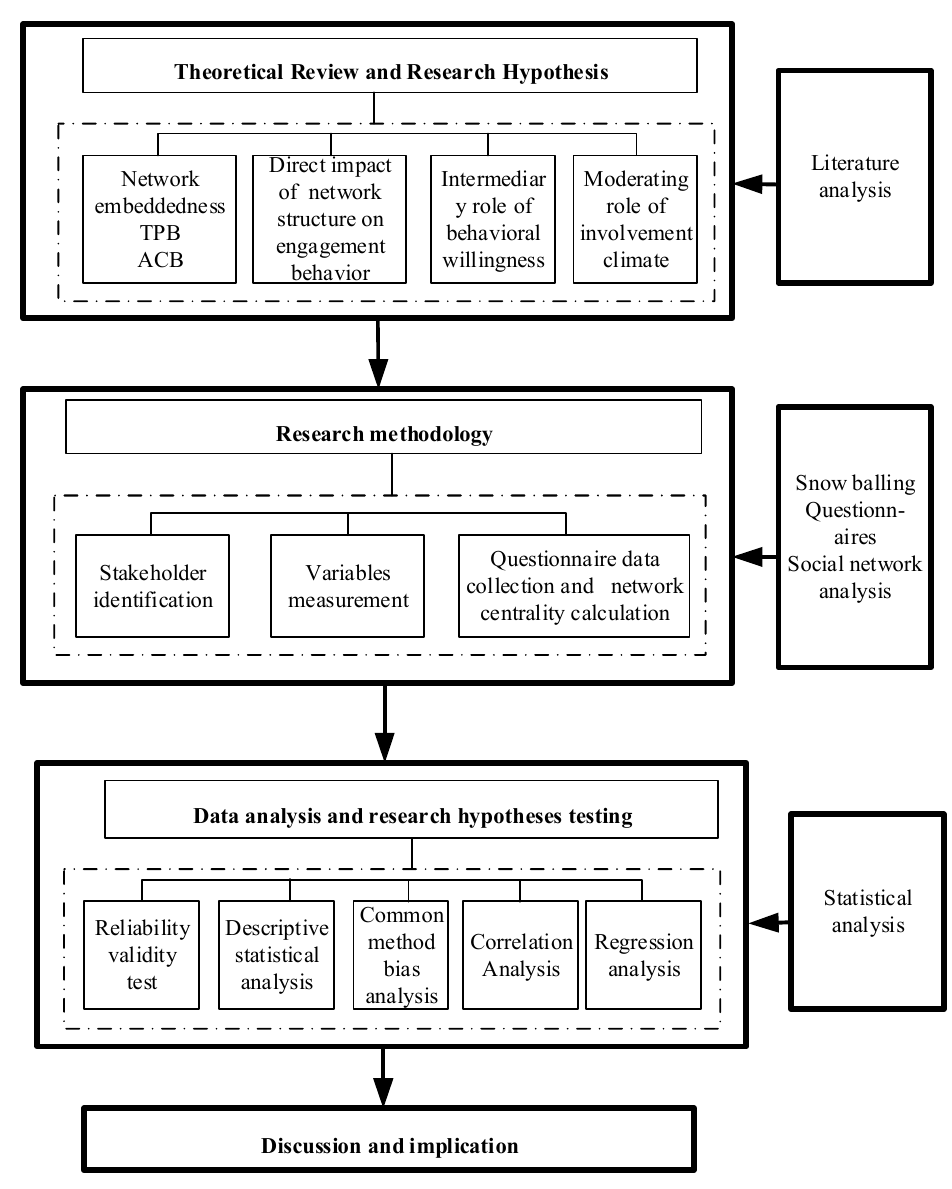
Figure 1. A framework for analyzing the influence of relationship network structure on engagement behavior.